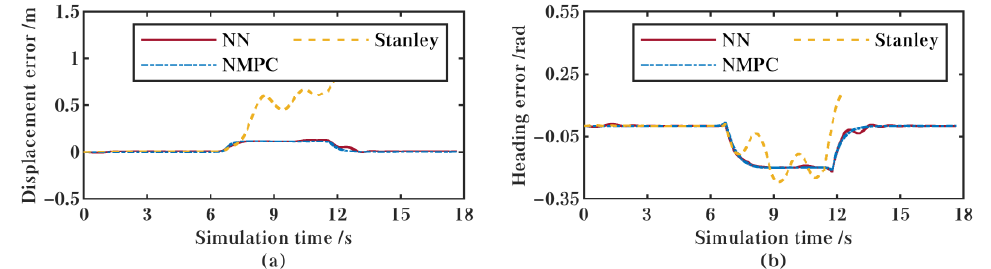
Figure 5. The errors of the comparison simulation: ( a ) the displacement error; ( b ) the heading error.